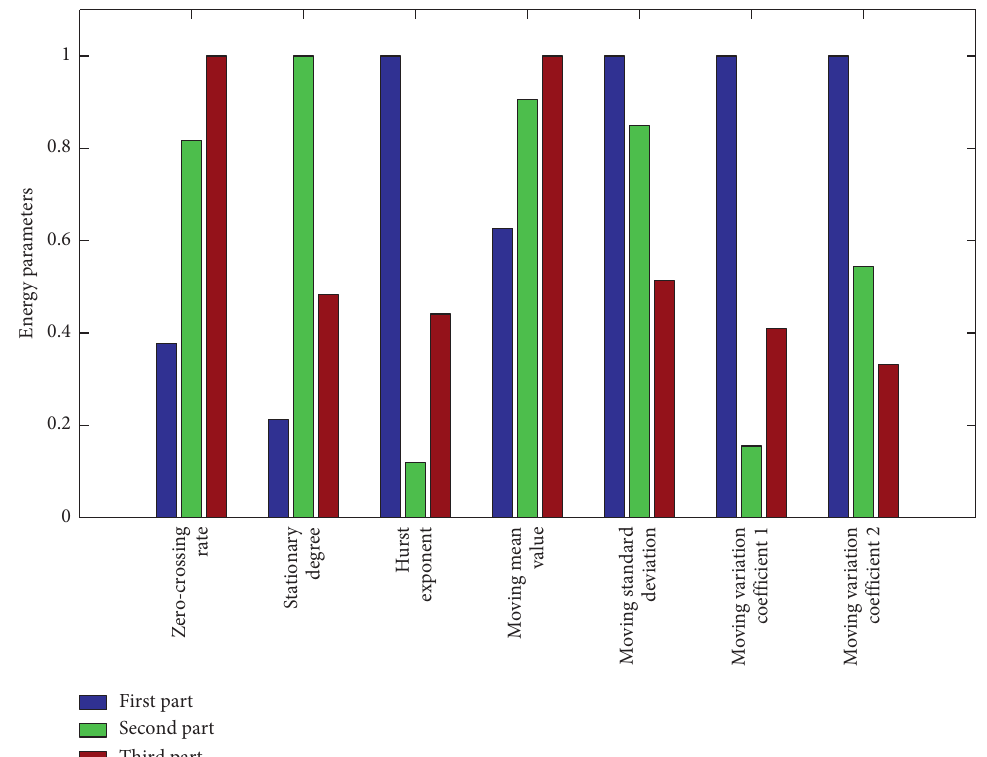
Figure 12: Nonstationarity energy index of ECG